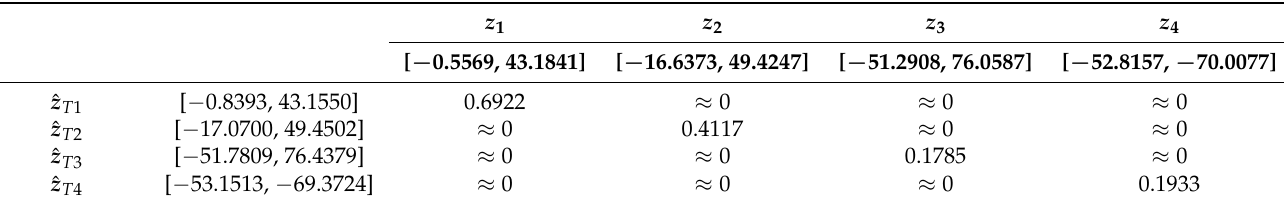
Table 2. Data association results when t k = 0.